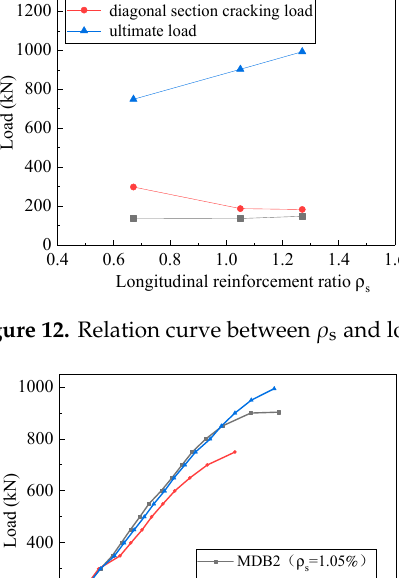
Figure 13. Relation curve between ρ s and deflection.